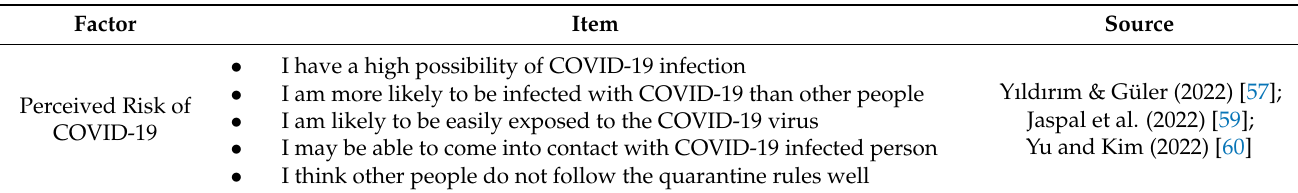
Table 3. COVID-19 risk perceived by active senior